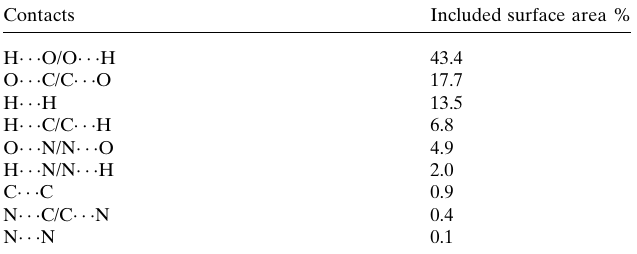
Table 2 Percentage contributions to the Hirshfeld surface for [Zn(DNBA) 2 (En)]. Contacts